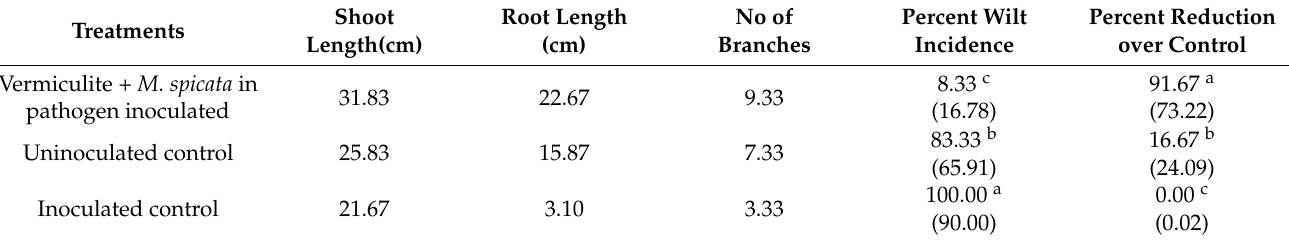
Table 1. Efficacy of VOCs immobilized vermiculite ball against F. oxysporum f. sp. lycopersici .